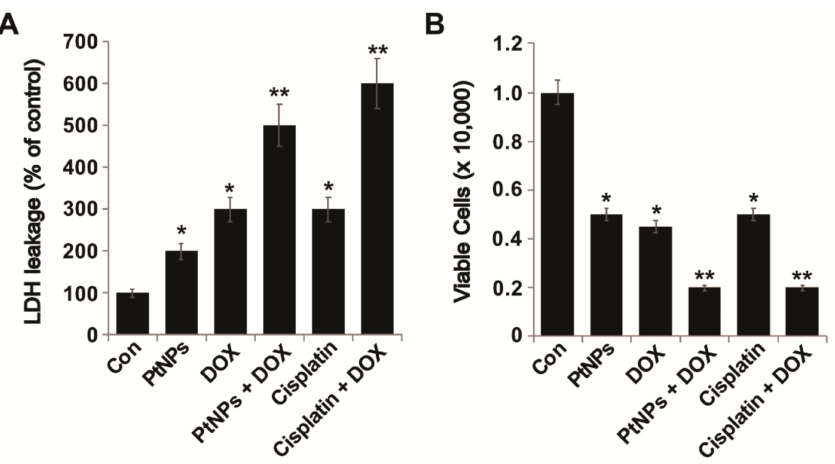
Figure 6. PtNPs and DOX increase LDH leakage and cell death. U2OS cells were treated with PtNPs (10 µ g / mL), DOX (1 µ g / mL), CIS (5 µ g / mL), or a combination of PtNPs (10 µ g / mL) and DOX (1 µ g / mL) or combination of DOX (1 µ g / mL) and CIS (5 µ g / mL) for 24 h. ( A ) LDH activity was measured at 490 nm using an LDH cytotoxicity kit; ( B ) cell death was quantified using a trypan blue assay.